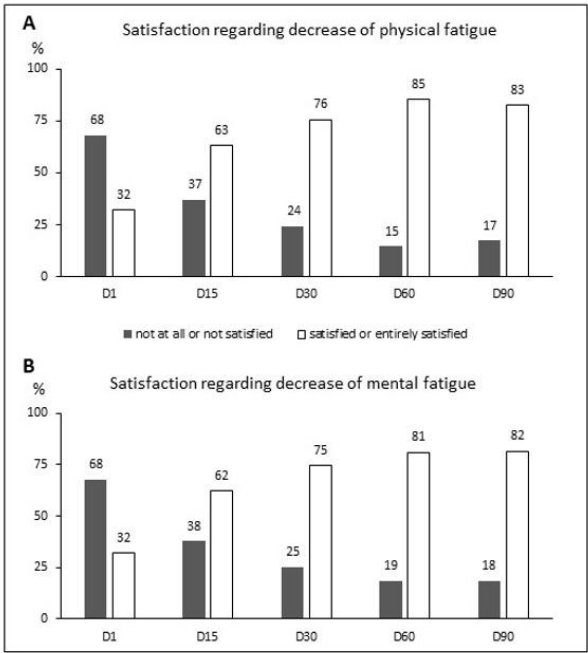
Figure 1. Percentage of population self-reporting the indicated level of satisfaction regarding the ability of the product to reduce physical fatigue ( A ) and mental fatigue ( B ), from D1 to D90 following supplementation. D—day.